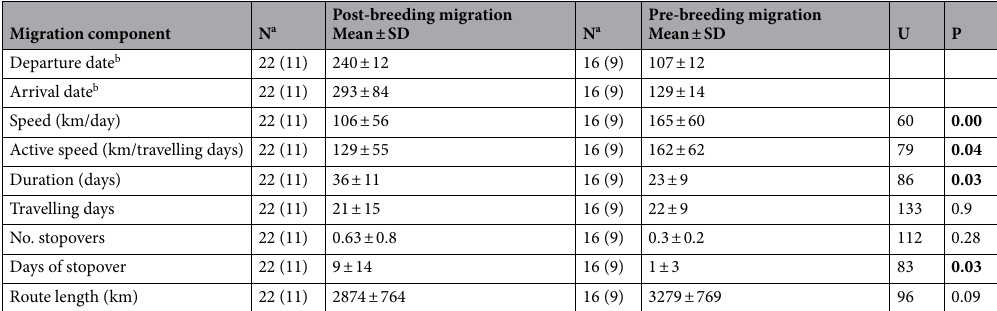
Migration component N